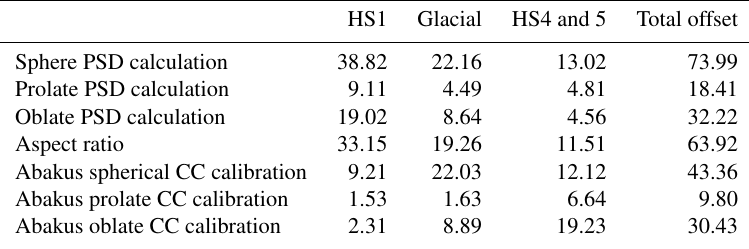
Figure 2. Representative ellipsoidal and spherical particles with labeled axes showing (a) prolate ellipsoidal particle shape with a FlowCAM image of an SPC14 particle, (b) oblate particle with rotated image of the particle from panel (a) (because particle images are in 2D we cannot differentiate between oblate and prolate), and (c) spherical particle shape with a FlowCAM image of an SPC14 particle. Left-hand images are representations of hypothesized axis measurements and geometries. For each particle, the assumptions and geometric volume calculations are provided. The volume calculations highlight the large difference in particle volume between equal and unequal axes (Eq. 1). Table 1. Total offset measures for each calibration methodology relative to PSD CC values. Total offset is minimized for prolate CC calibra- tion, making it the preferred approach for this